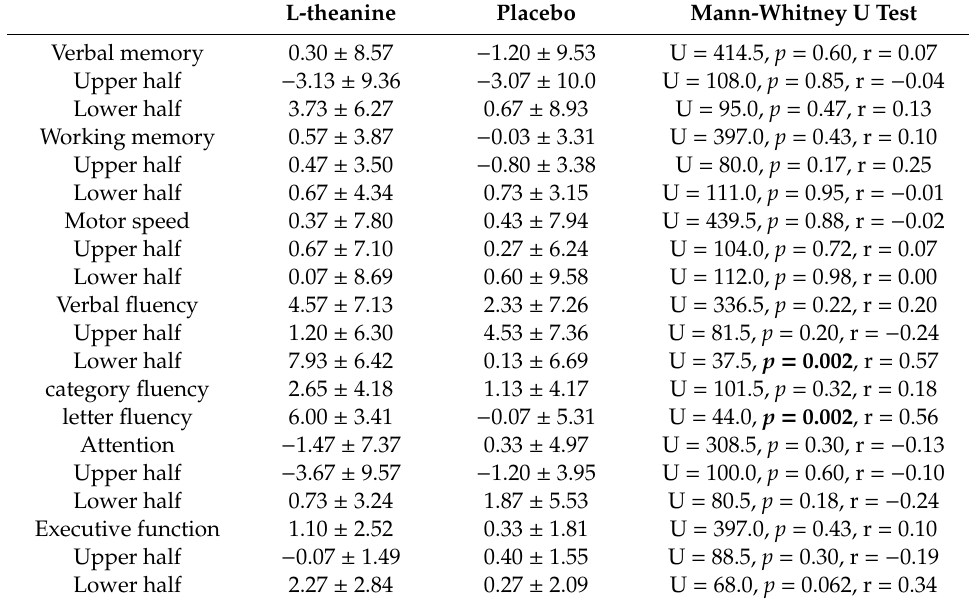
Table 4. Comparisons of BACS score changes between 4 weeks L-theanine and placebo administrations stratified by the median split based on mean pretreatment